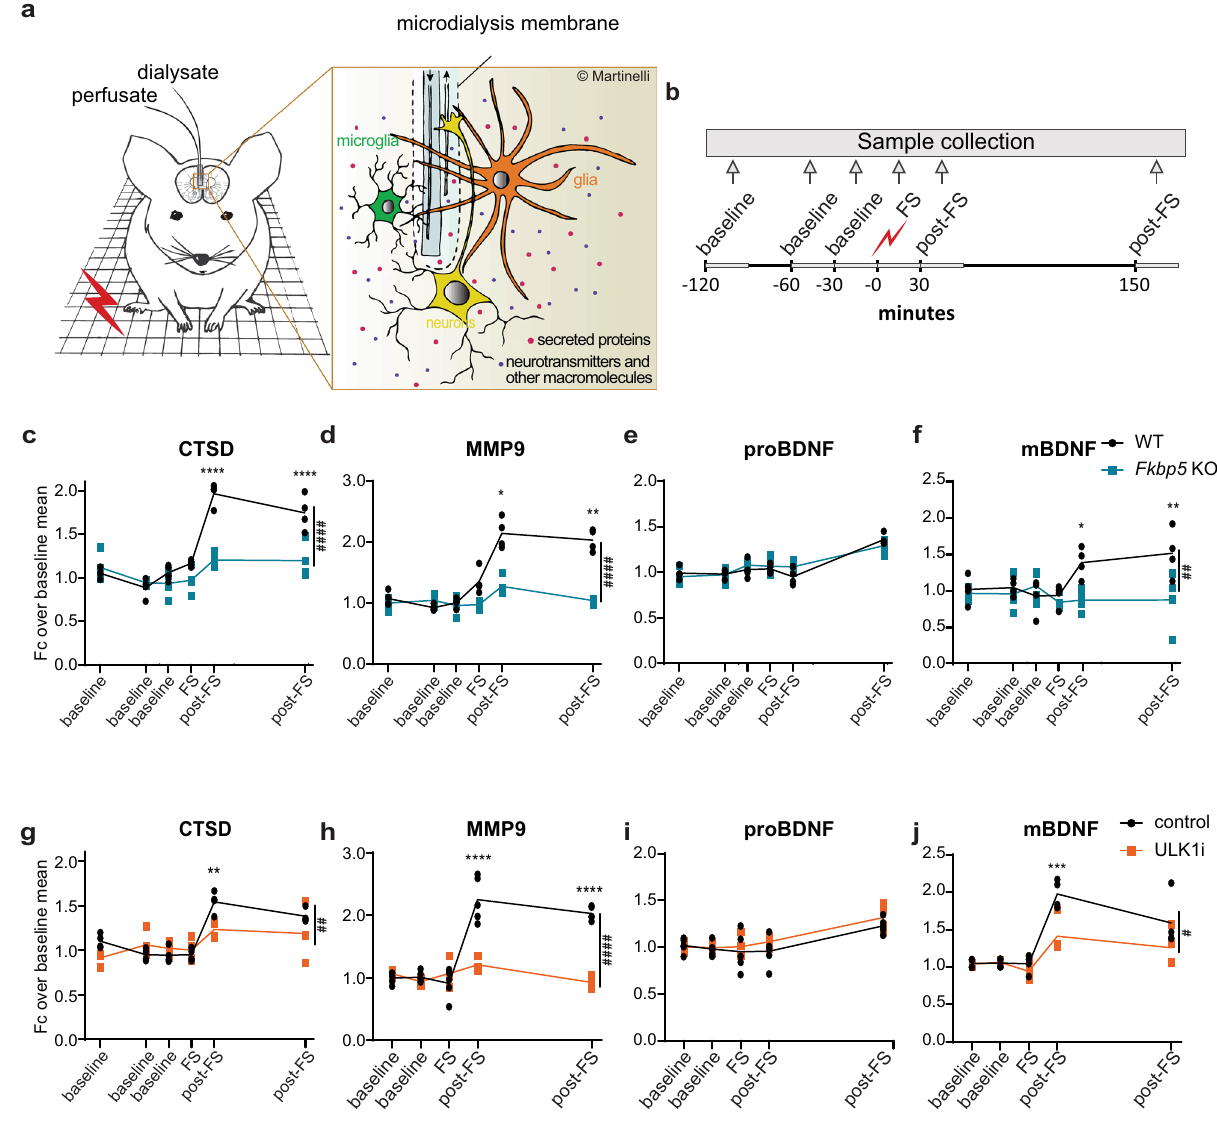
Fig. 5 Stress enhances secretory autophagy and increases the mBDNF/proBDNF ratio in vivo. a Schematic overview of in vivo microdialysis. b Experimental design and timeline; each sample was collected over 30 min indicated by the light gray lines. Quanti fi cations of c CTSD , d MMP9 , e proBDNF, and f mBDNF from in vivo mPFC microdialyses of WT and Fkbp5 KO mice. Quanti fi cations of g CTSD, h MMP9, i proBDNF, and j mBDNF from in vivo mPFC microdialyses of WT mice injected intraperetoneally with ULK1 inhibitor (ULK1i) or saline. n = 4 mice per group. Two-way ANOVA with Š ídák ’ s multiple t -test was performed; * P < 0.05; ** P < 0.01; *** P < 0.001; **** P < 0.0001. Hash symbol refers to time × genotype/treatment interaction. Data shown as mean ± s.e.m. FS foot shock, Fc fold